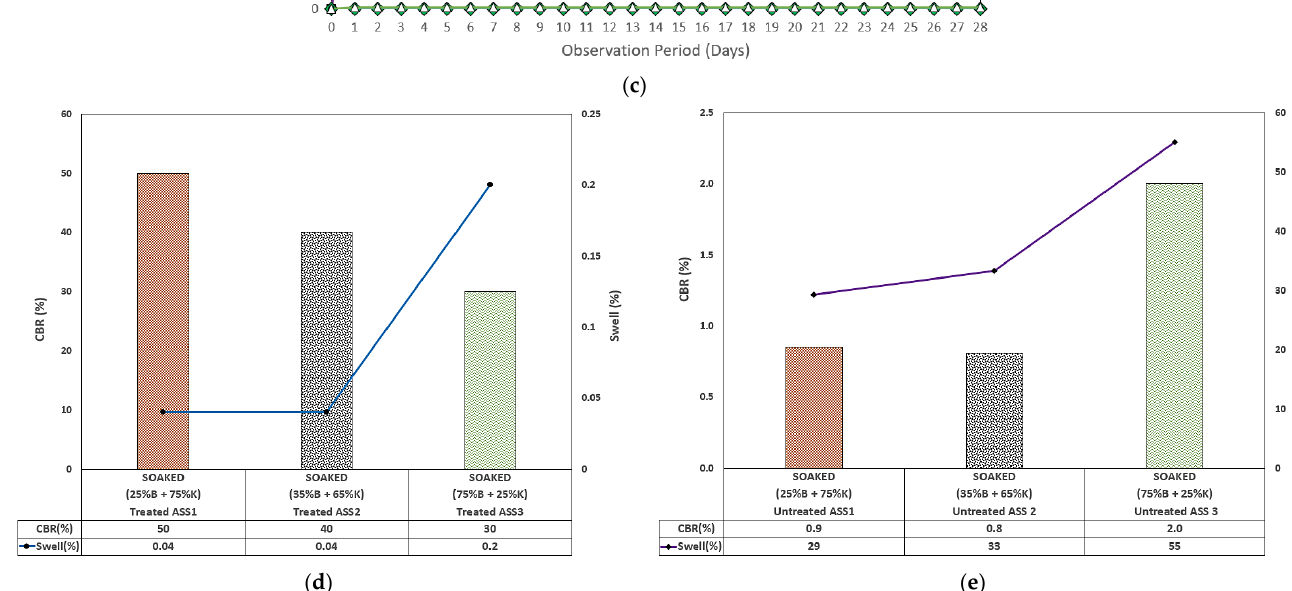
Figure 11. ( a ) Results for the untreated ASS materials; ( b ) results for the treated ASS; ( c ) combined swell result for untreated and treated ASS materials; ( d ) day 4 untreated-soaked CBR values against day 4 swell, where B = bentonite and K = kaolinite; ( e ) day 4 treated-soaked CBR values against day 4 swell, where B = bentonite and K = kaolinite .